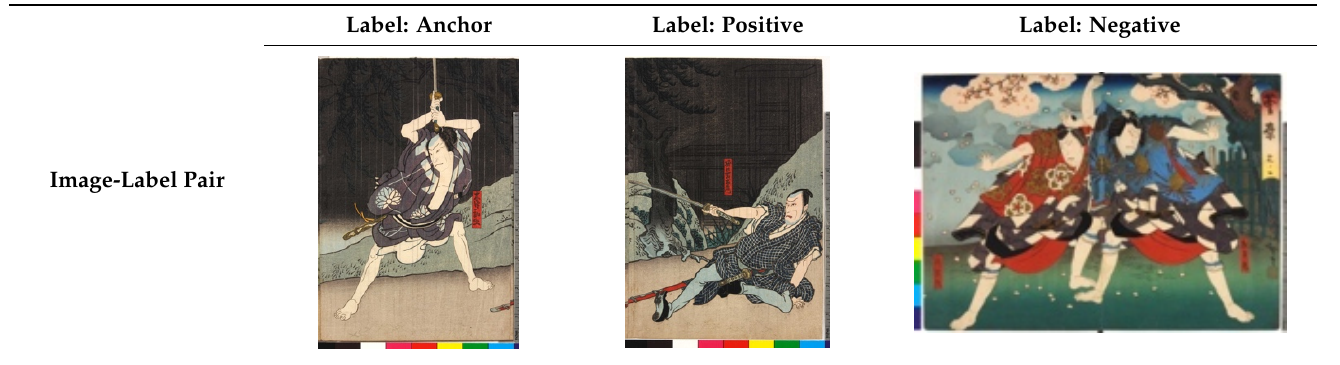
Table 2. Fine-tuning for learning image representation focused on the similarity of the sketch structure.